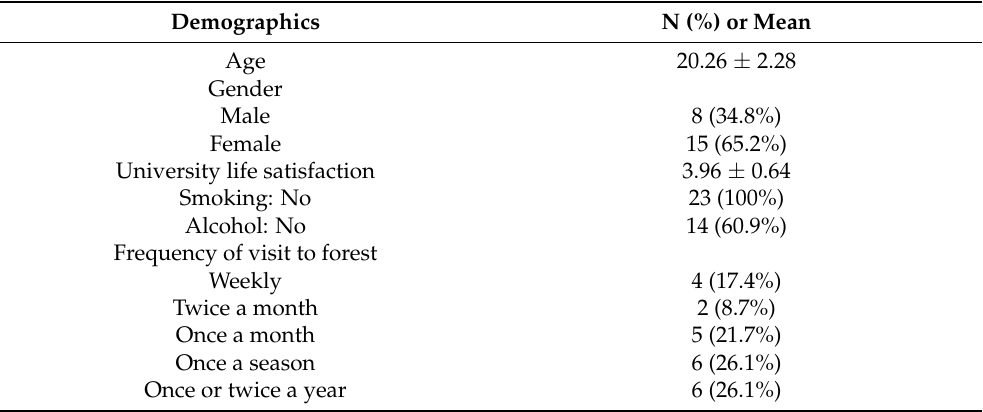
Table 1. Demographics’ information.